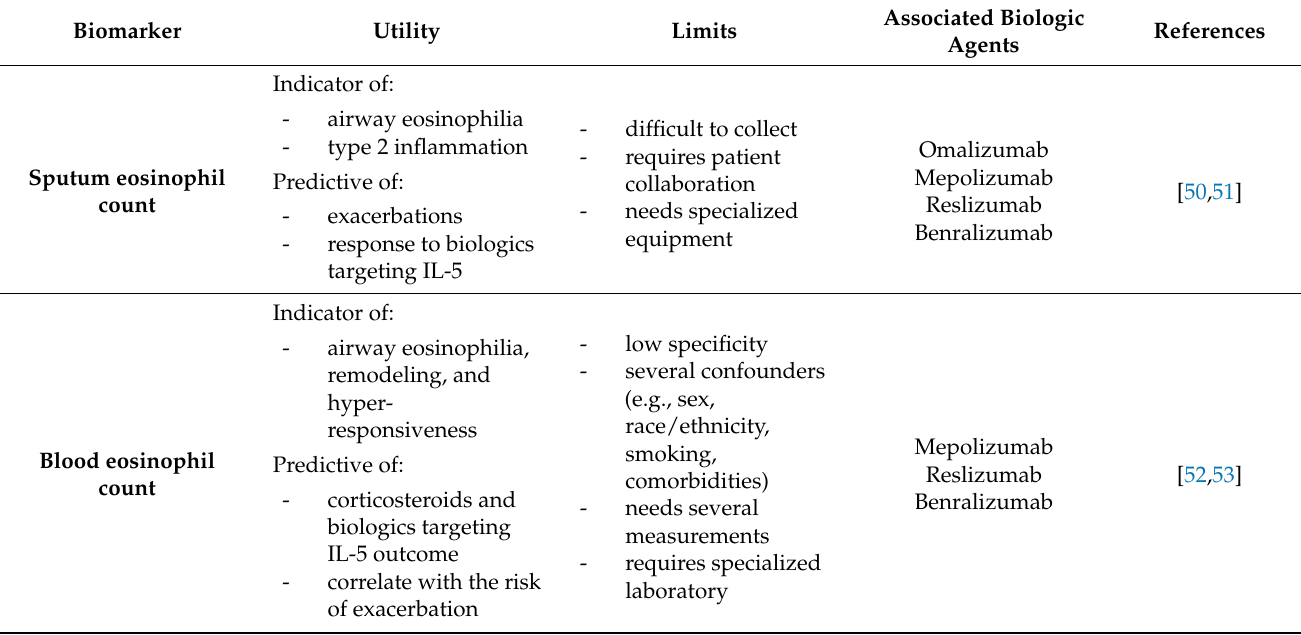
Table 1. Current and potential future biomarkers for severe